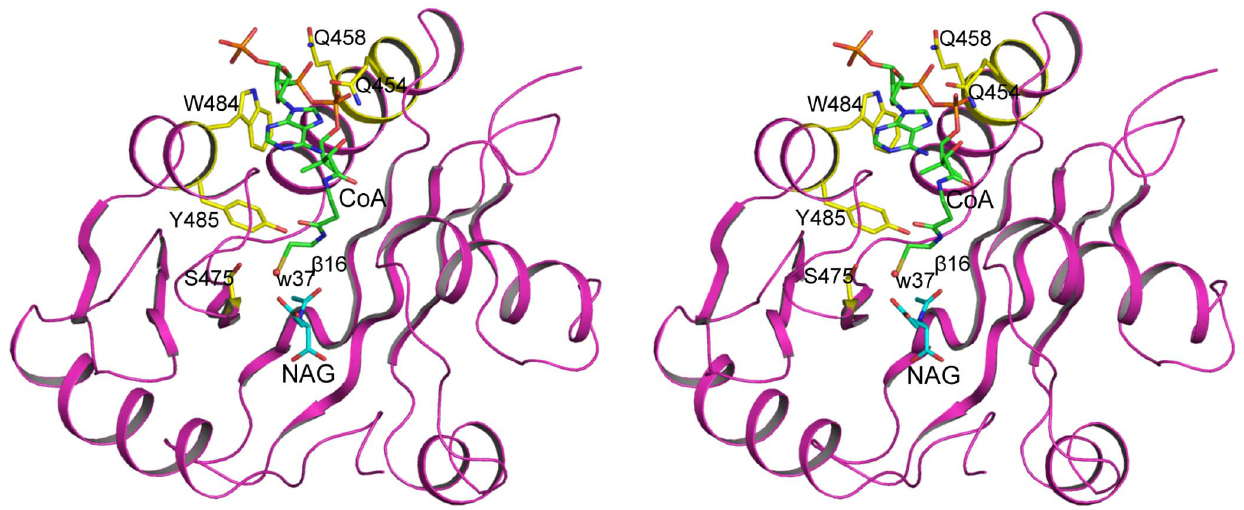
Figure 5. Stereo diagram of the proposed CoA binding site. The proposed bound CoA is shown in green sticks. The bound NAG is shown in sky-blue sticks. Side-chains of residues that potentially hydrogen bond to CoA are shown in yellow sticks. The water molecule (w37) that occupies the similar position of thiol S of CoA is shown in a red ball.